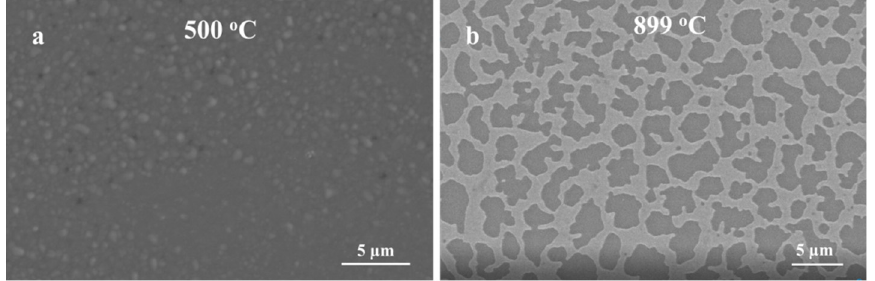
Figure 8. SEM images of the annealed Ag thin film of different thickness on quartz. ( a ) 5 nm Ag, ( b ) 300 nm Ag.